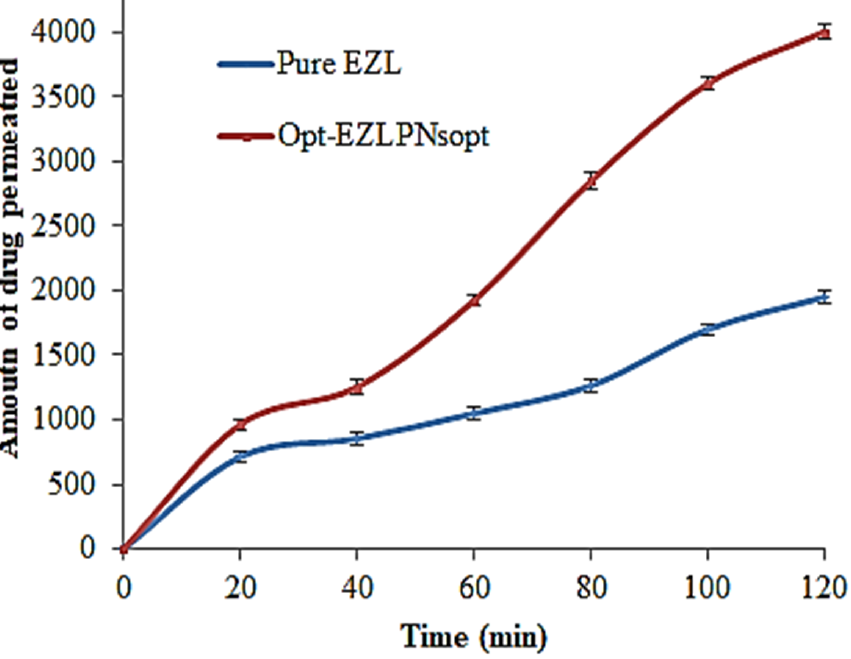
Figure 10. Ex ‐ vivo gut EZL permeation profile from pure EZL and EZL ‐ PNsopt. Figure 10. Ex-vivo gut EZL permeation profile from pure EZL and